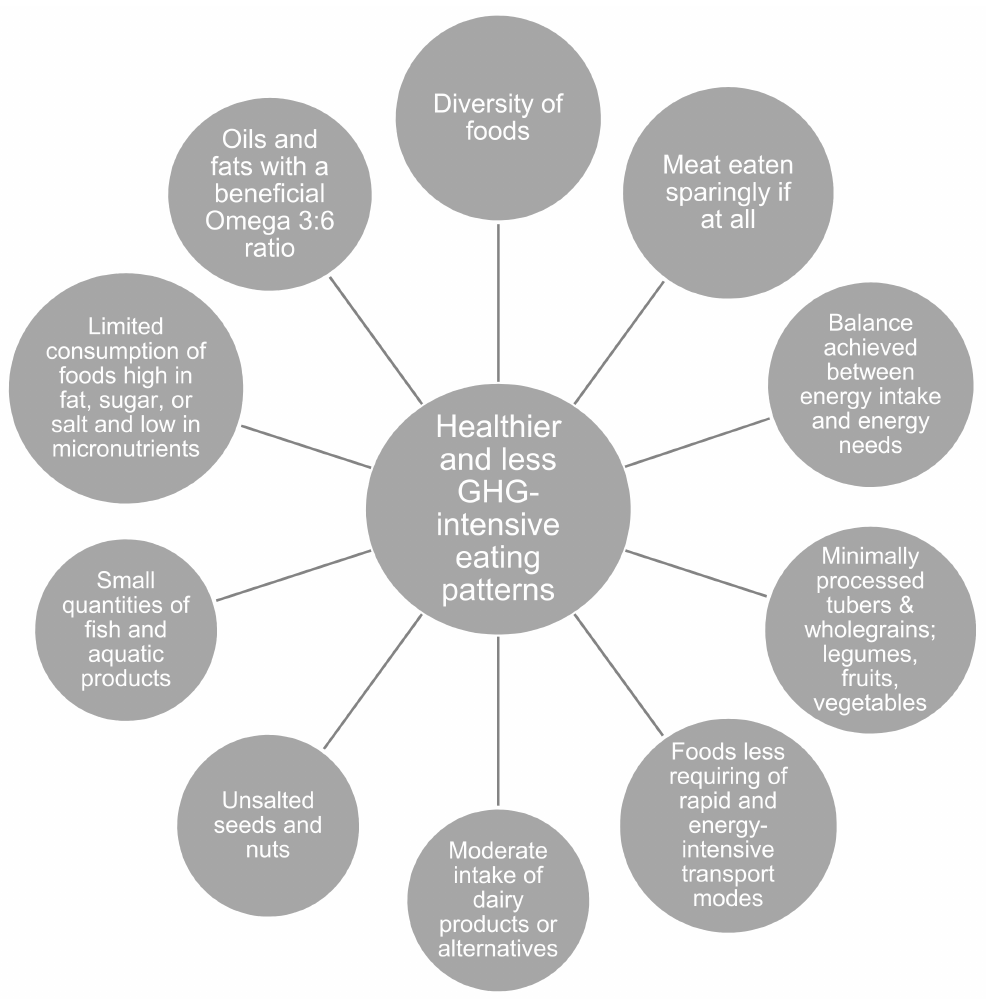
Figure 1. Characteristics of healthier and less land-intensive eating patterns with fewer greenhouse gas emissions (own version according to Garnett